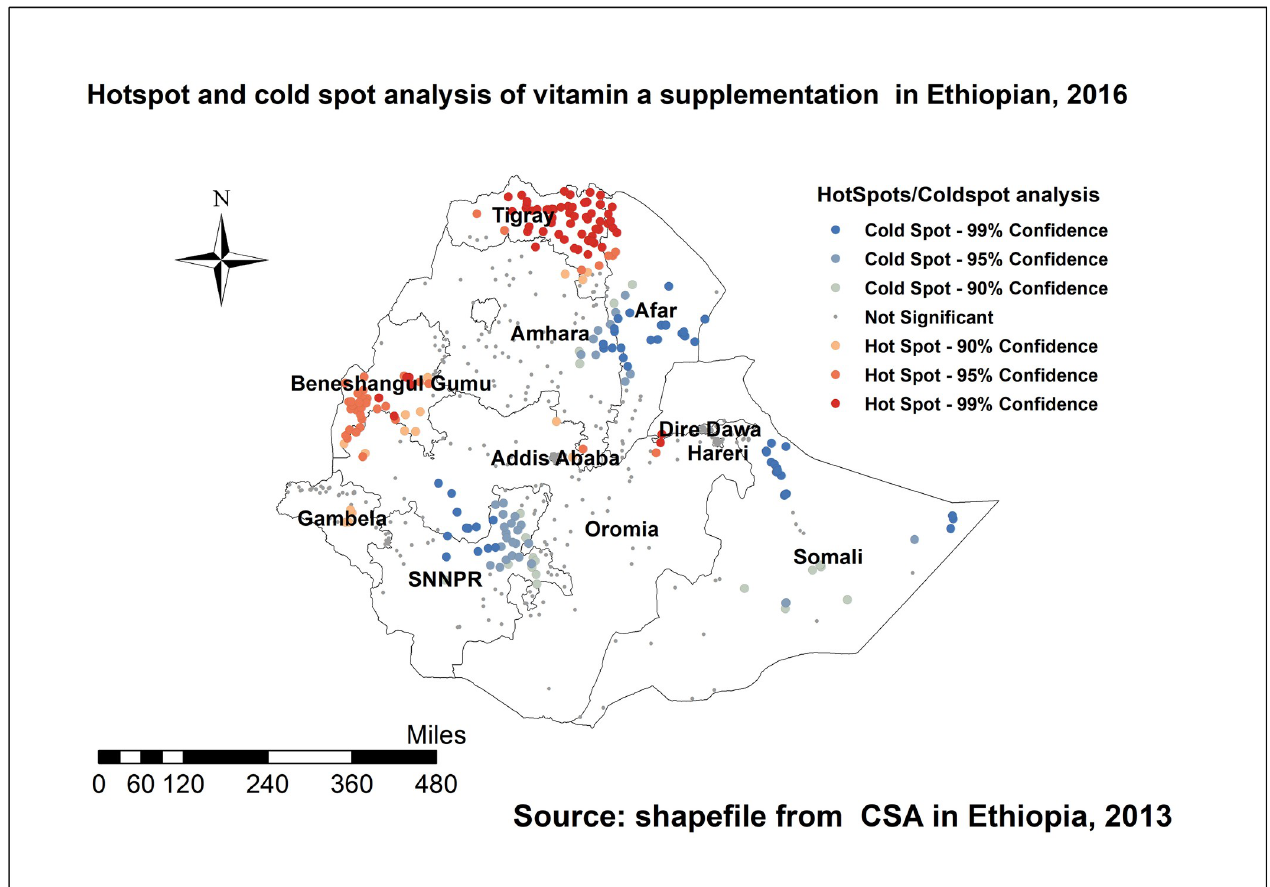
Fig 2. Spatial distribution of vitamin A supplementation among children aged 6–59 months in Ethiopia, EDHS 2016.